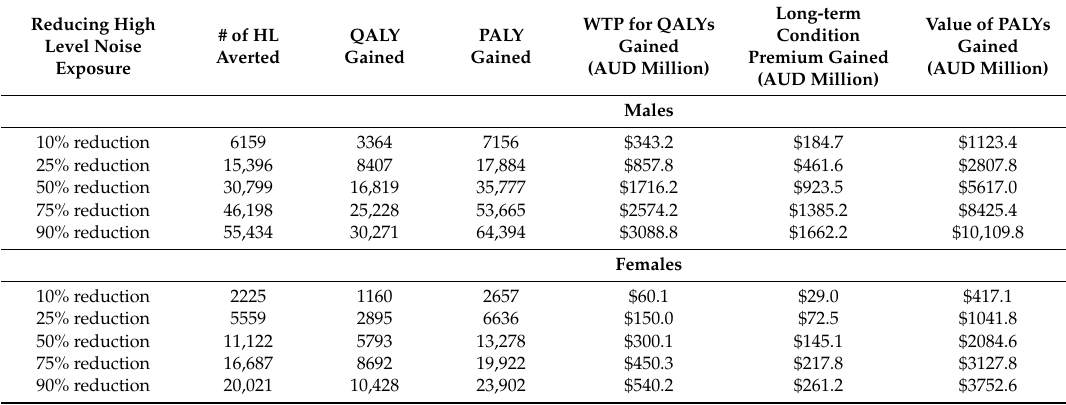
Table 2. E ff ects of reducing high level noise exposure ( > 90 dB) to lower level exposure (85–89 dB) and lower level exposure to no exposure ( < 85